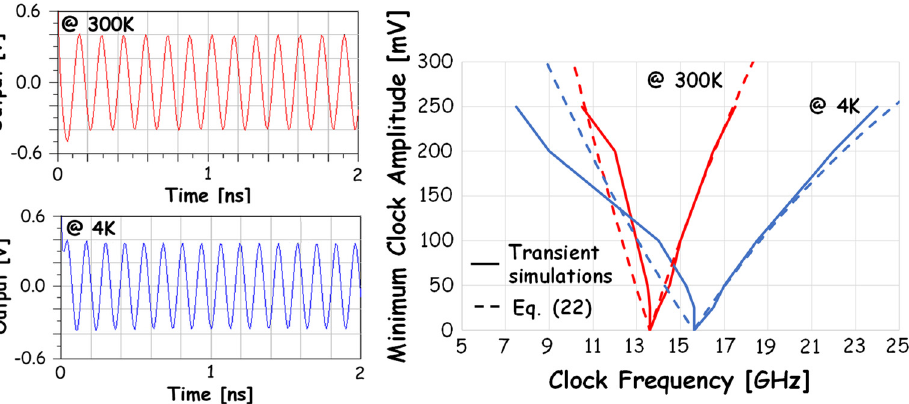
Figure 8. Self-oscillation differential output waveforms (on the left ) and sensitivity curves (on the right ) of the Frequency Divider.